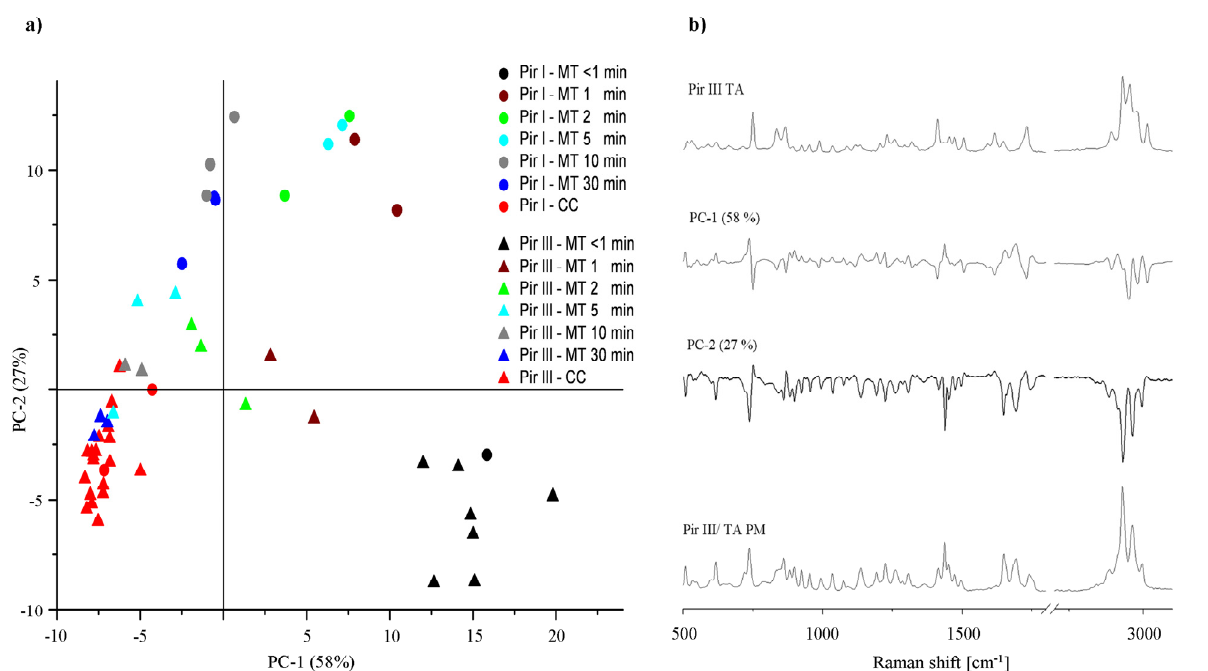
Figure 11. ( a ) PCA 2D score plot of piracetam form I or form III dry-ground with tartaric acid. ( b ) Loadings plots of PC-1 and PC-2, Raman spectra of Pir III/TA PM and Pir III TA for